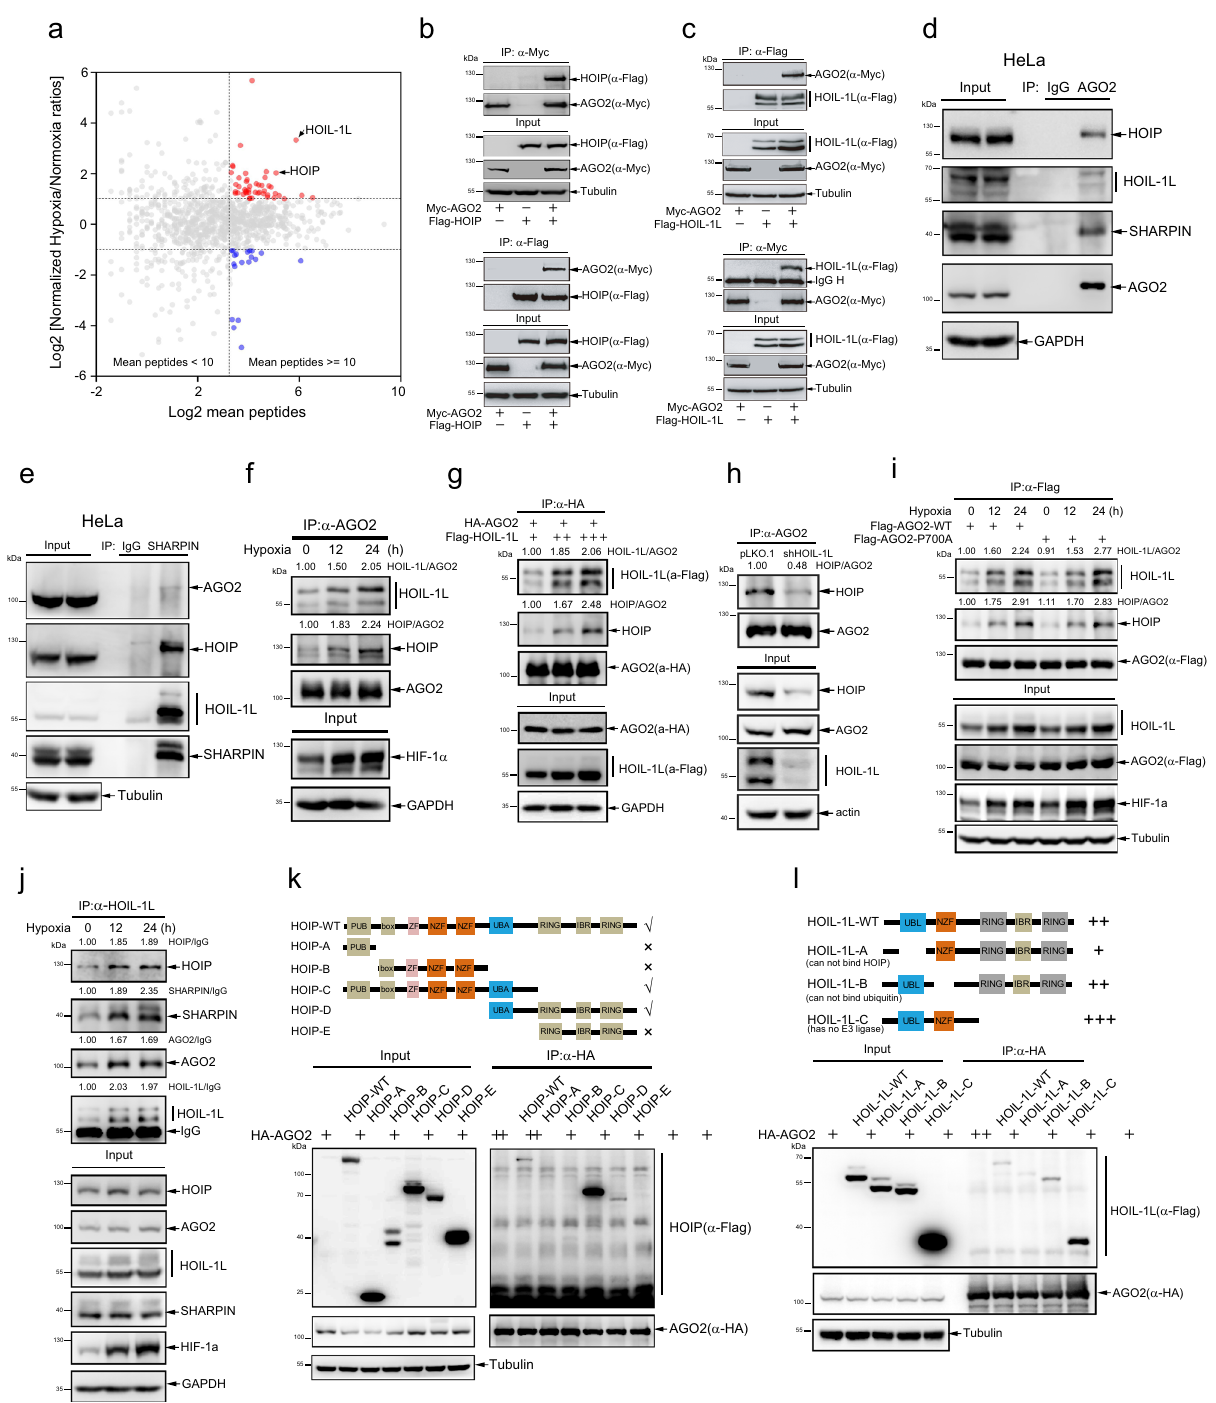
interaction with HOIP and HOIL-1L under hypoxia stress (Fig. 2i). Moreover, to explore whether the induced HOIL-1L by hypoxia recruits more AGO2, HOIP or/and SHARPIN, HeLa cells treated with hypoxia for indicated times were lysed for co-IP with anti-HOIL-1L antibody, and then followed by Western blotting, which showed that hypoxia increased the association of HOIL-1L with HOIP, SHARPIN and AGO2 (Fig. 2j). We further examined the domains of HOIP or HOIL-1L that are involved in their protein-protein interaction with AGO2, Flag-tagged full length of HOIP or HOIL-1L and their domain deletion/truncated forms were co-transfected with HA-tagged AGO2 into 293T cells,